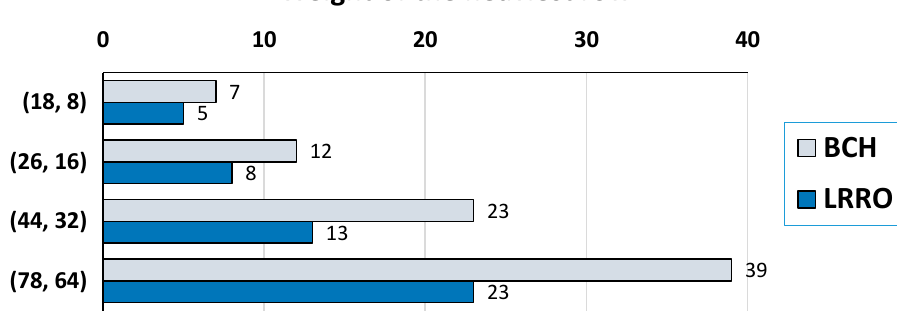
Figure 4. Hamming weights of the whole matrix. 4.2. Implementation and Logic Synthesis All LRRO DEC codes presented in this paper, as well as the considered BCH DEC codes, have been implemented and simulated to check if they achieve the expected error coverage. We implemented a simulation-based error injection tool [21] with which we could analyze the error coverage of the different ECCs. This tool can inject diverse error models. Particularly, single and multiple random errors were injected. These errors emulate bit-flips in memory cells. The basic scheme of our error injector is shown in Figure 5. This tool can verify whether the injected error provokes an incorrect or a correct decoding. To do this, the simulation-based error injector tool compares the input and output words. As expected, all of the studied codes corrected 100% of single and double errors. Figure 5. Block diagram of the error injector [21].